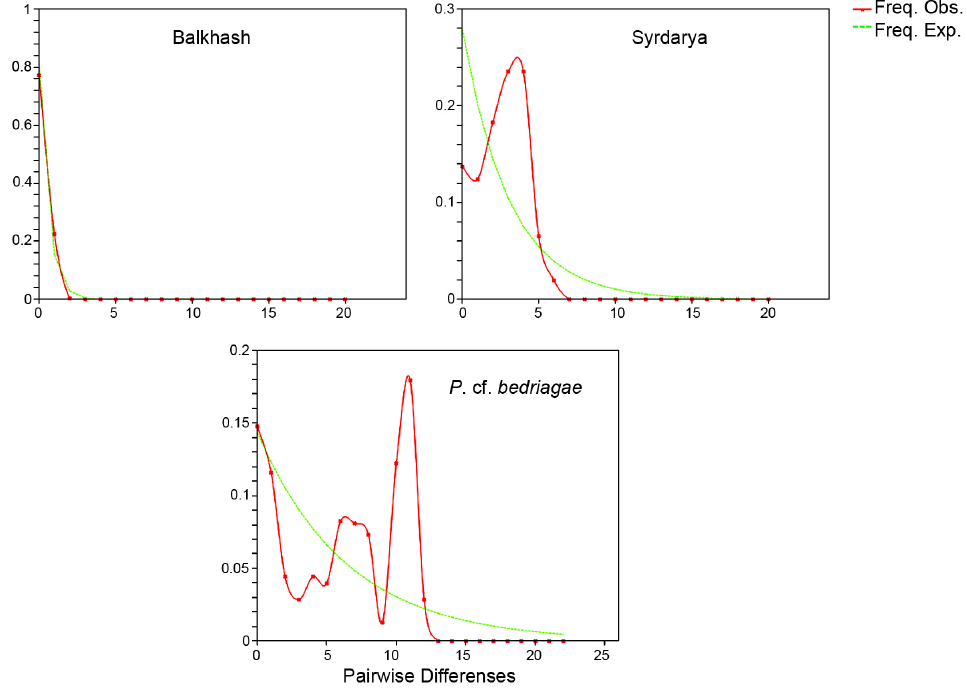
Figure 5. Mismatch distribution plots based on combined COI + ND2 of mtDNA datasets. Multimodal graph indicates demographic equilibrium and unimodal graphs often indicate population expansion.